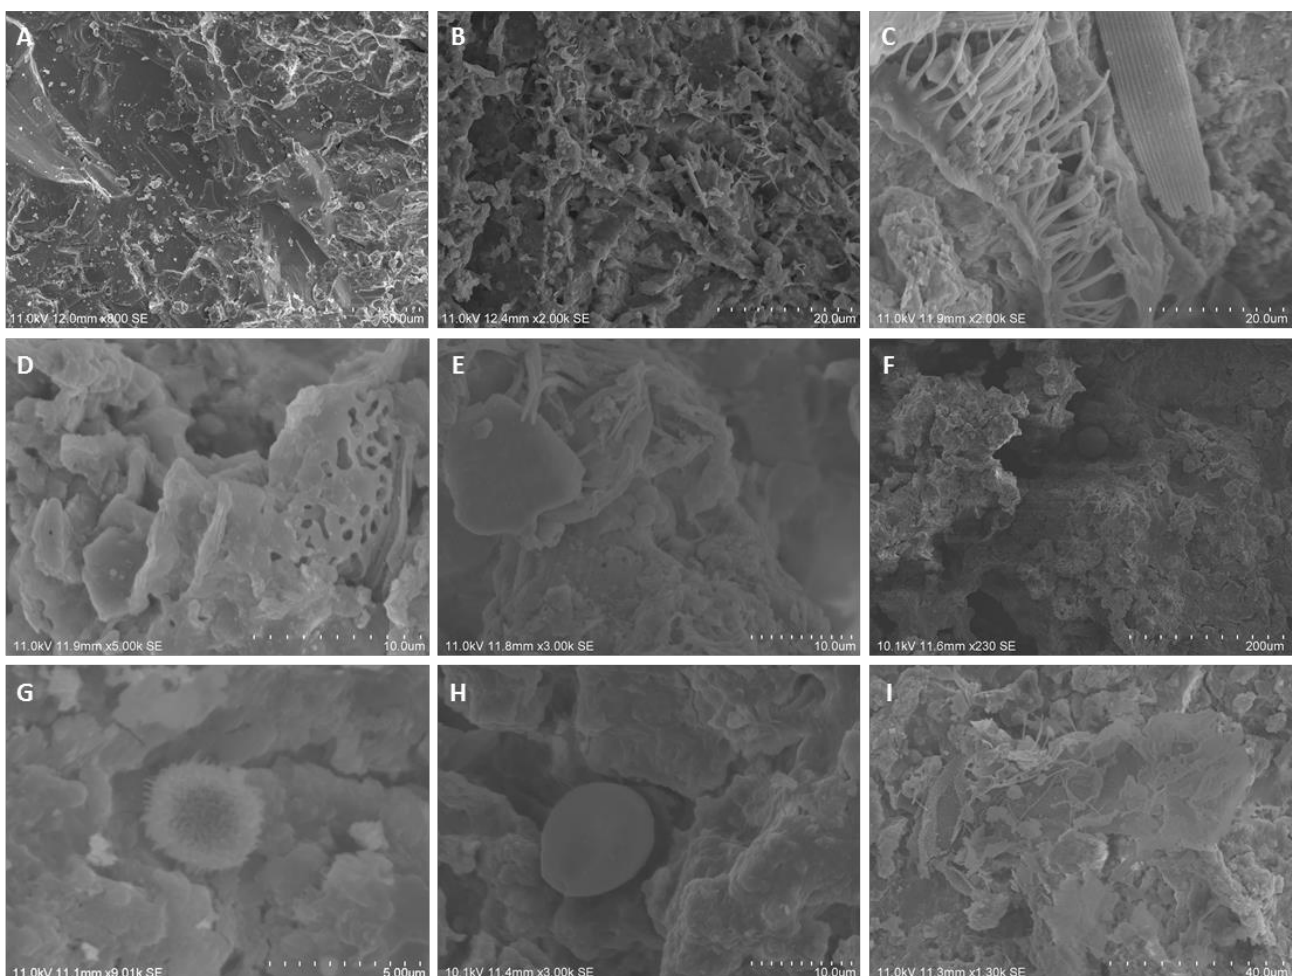
Figure 2. Micrographs from Escoural Cave showing the diversity of the microbial contamination in the samples from Escoural Cave. ( A ) Rock surface without microbial contamination. ( B ) Widespread fungal colonization of the rock surface with numerous hyphal structures ( C ) Hyphal structure developing over a micro-leaf and presence of an unidentified structure. ( D ) Bacterial EPS developing over the rock surface. ( E ) Fungal hyphae and bacteria. ( F ) Spherical unidentified structure of possibly microbial origin. ( G ) Microbial structure. ( H ) Fungal spore. ( I ) Arthropod’s corpse.